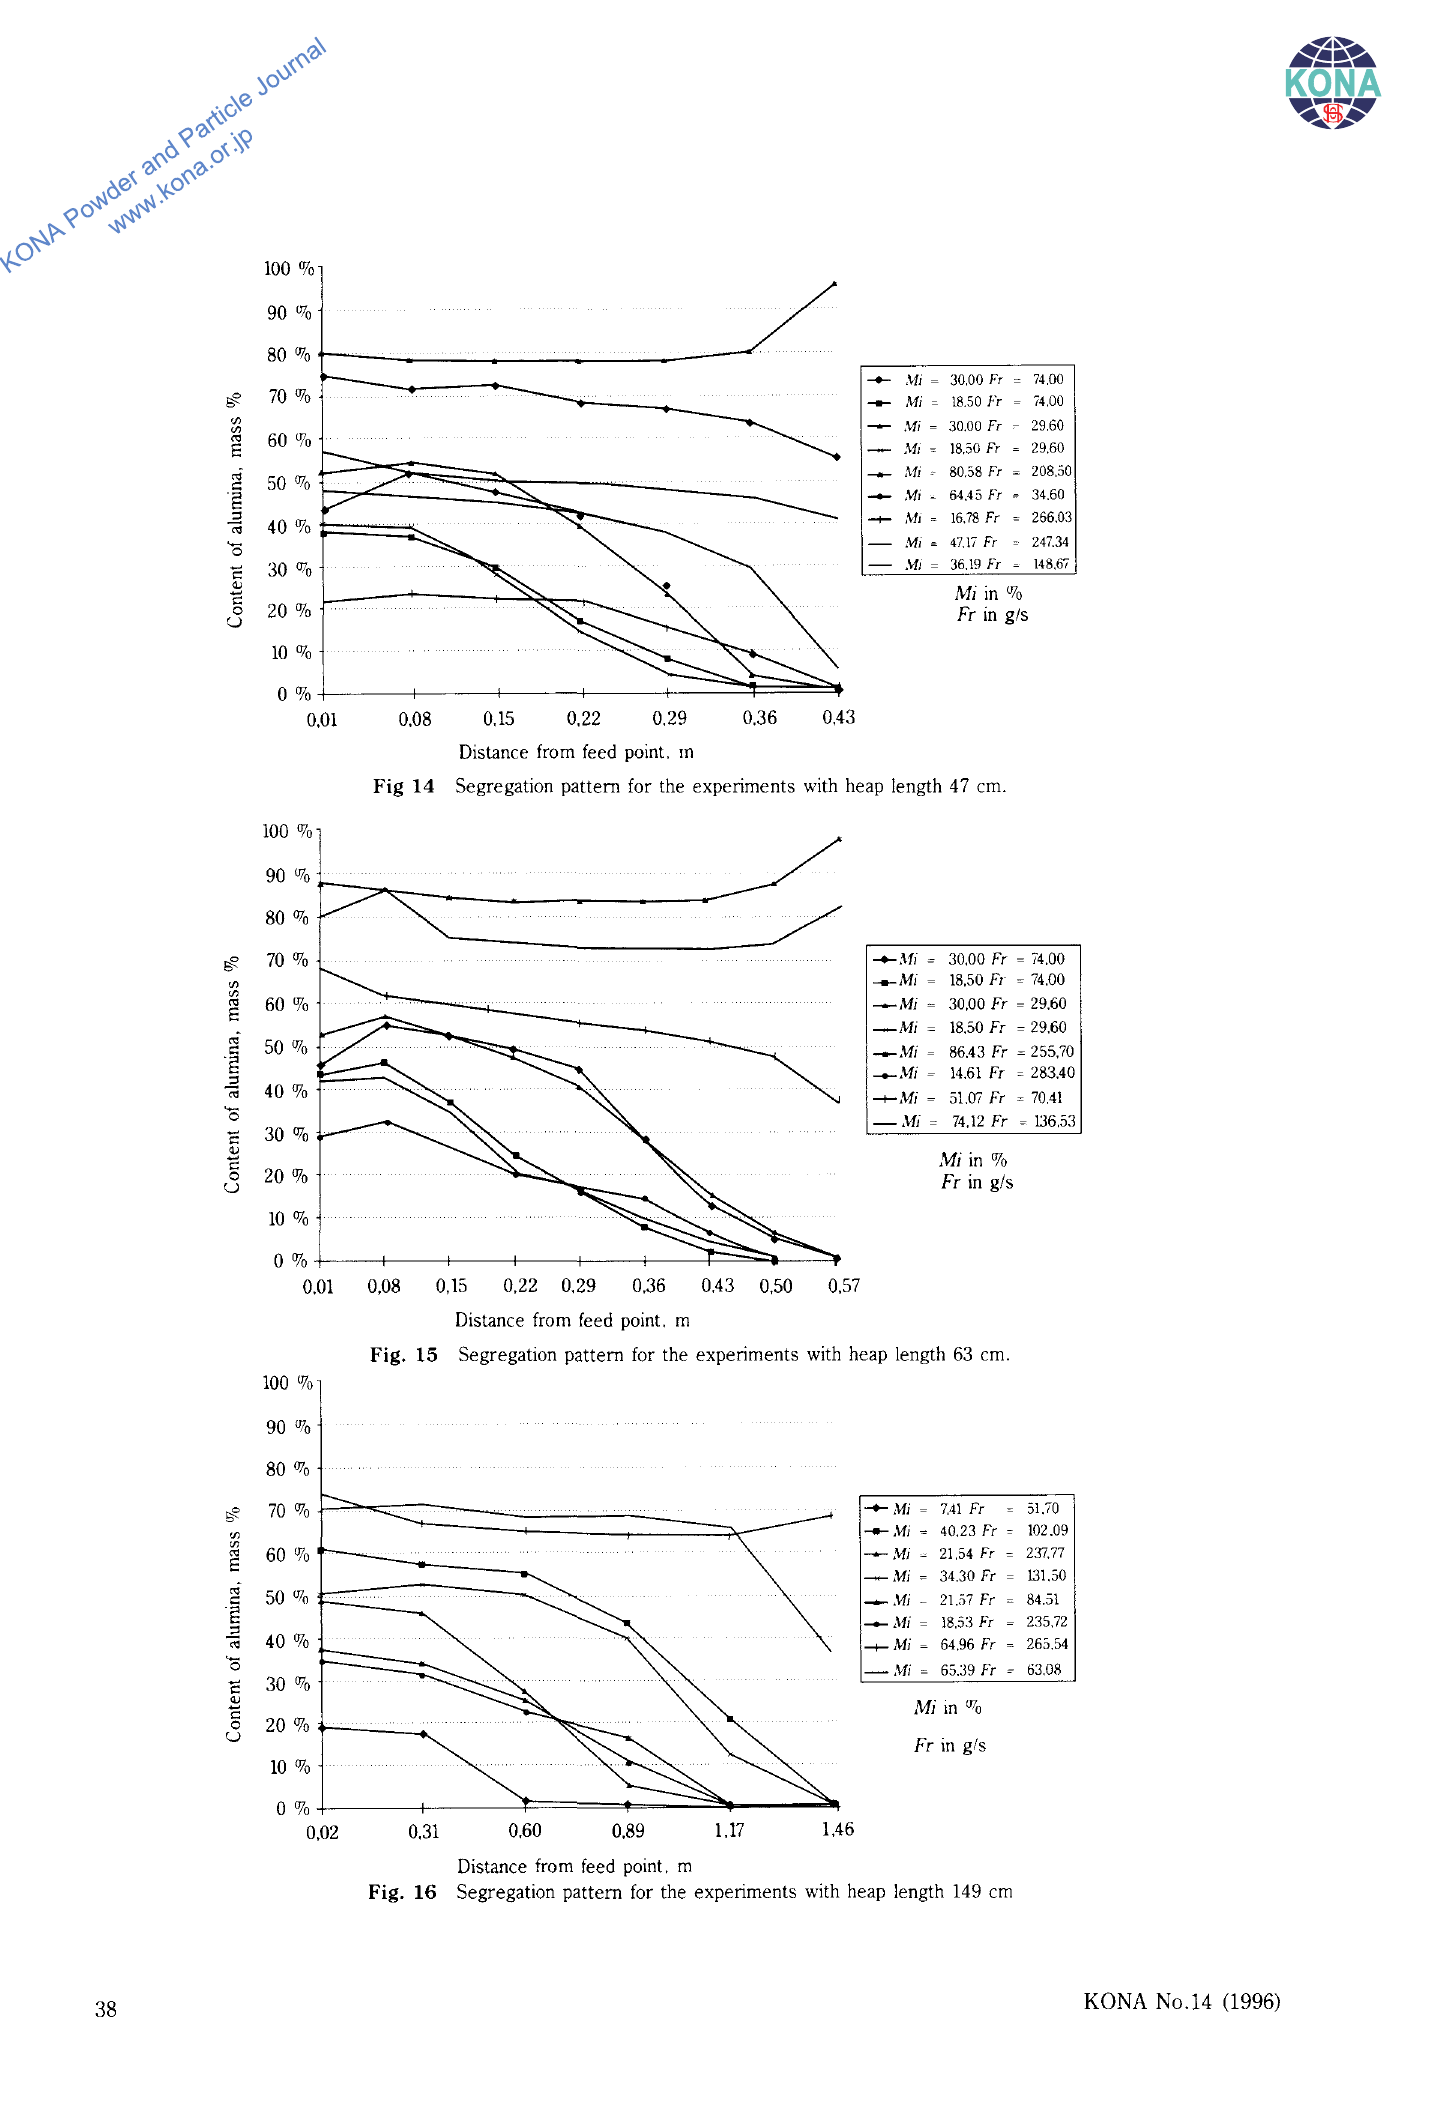
Fig 14 Segregation pattern for the experiments with heap length 47 em.